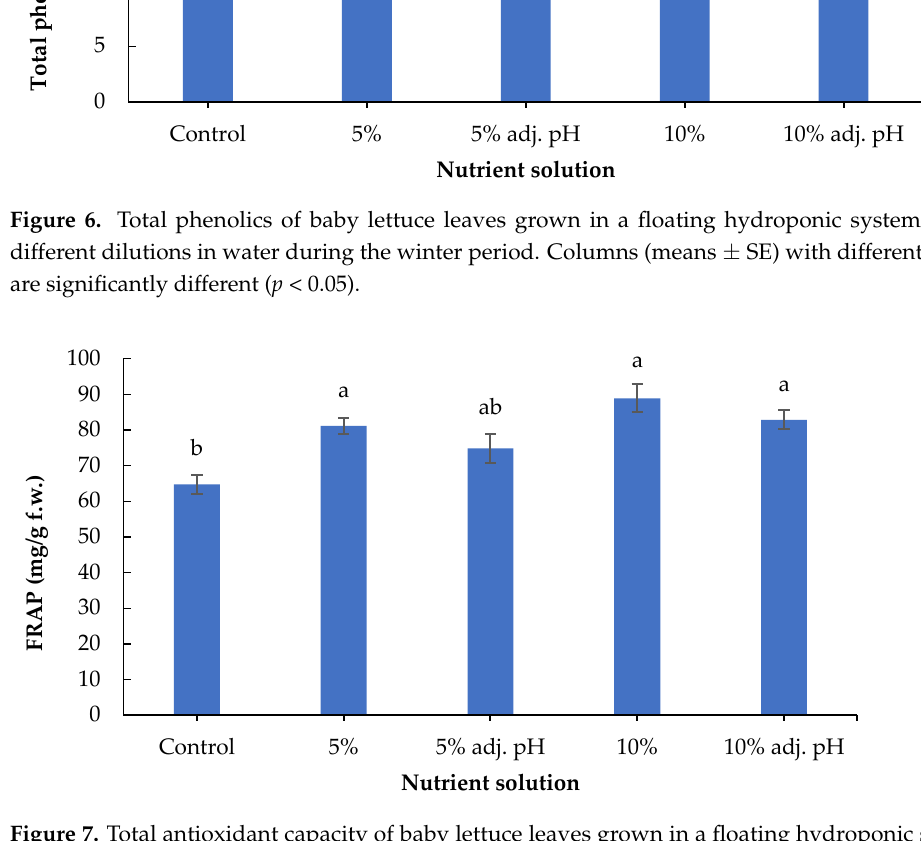
Figure 7. Total antioxidant capacity of baby lettuce leaves grown in a floating hydroponic system under different dilutions in water during the winter period. Columns (means ± SE) with different letters are significantly different ( p < 0.05).